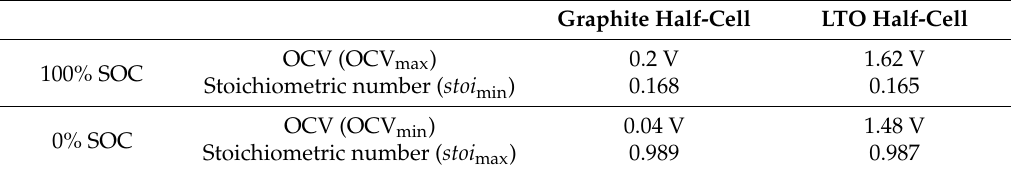
Table 1. Max. and min. values of open circuit voltage (OCV) and stoichiometric